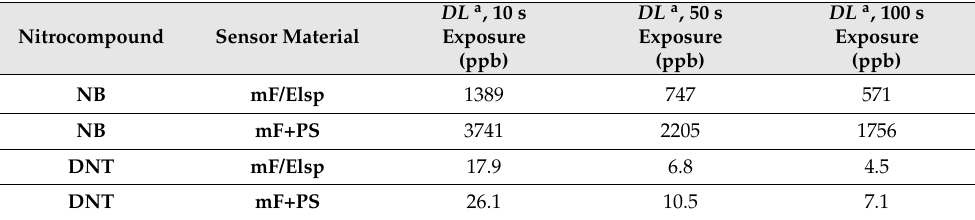
Table 3. Detection limits ( DL ) of NB and DNT vapors towards sensor materials mF/Elsp and mF+PS calculated via obtained model parameters.